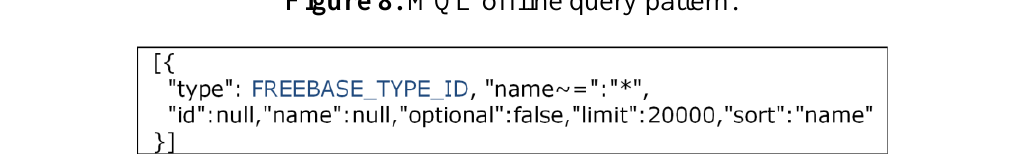
Figure 8. MQL offline query